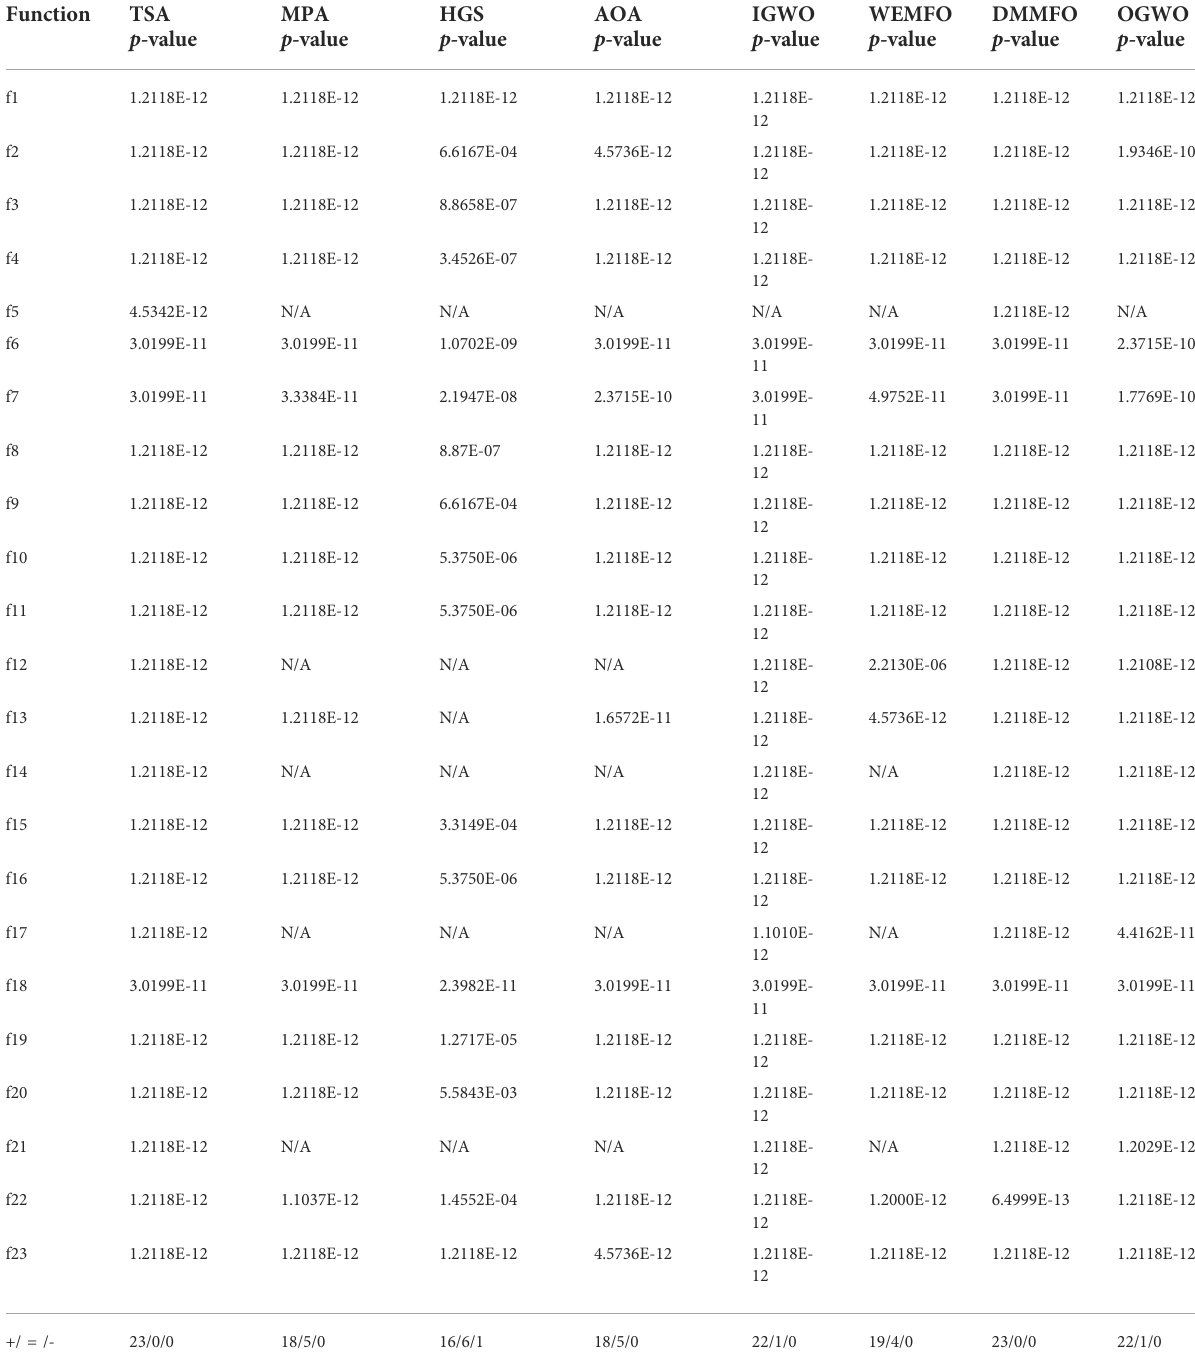
TABLE 6 Statistical conclusions based on Wilcoxon signed-rank test on 100-dimensional benchmark problems.